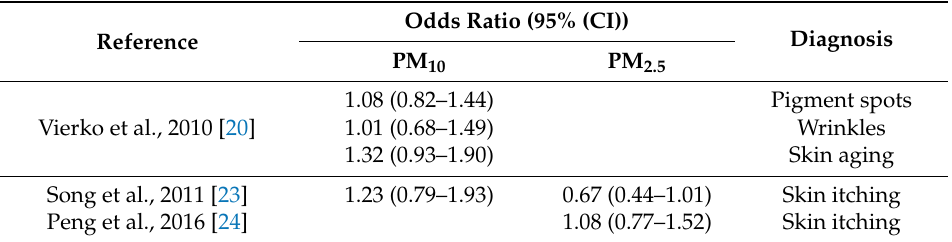
Table 2. Sizes of studies in primary meta-analysis. CI: confidence